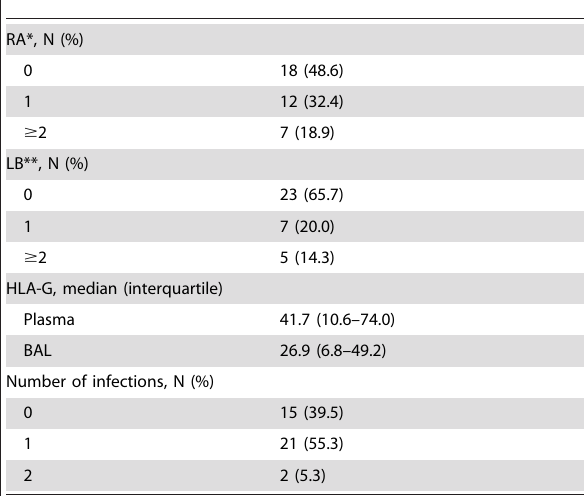
Table 2. Maximum grade A rejection (RA), lymphocytic bronchiolitis (LB), maximum HLA-G concentrations (U/ml), and presence of infection in 38 subjects prior to onset of